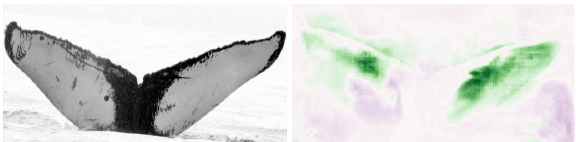
Figure 4. Occlusion sensitivity map as an overlay over an example image of the humpback whale identification data set, which shows an image of class 2155 . The result is computed for a patch size p = 5px . Pixels colored green illustrate regions whose overlap reduces the confidence score of class c , and which are therefore important for the classification of class c . Purple pixels indicate regions whose coverage increases the score, i.e. these regions point towards other classes. These areas can confuse the network during the classification process if these areas are located in the